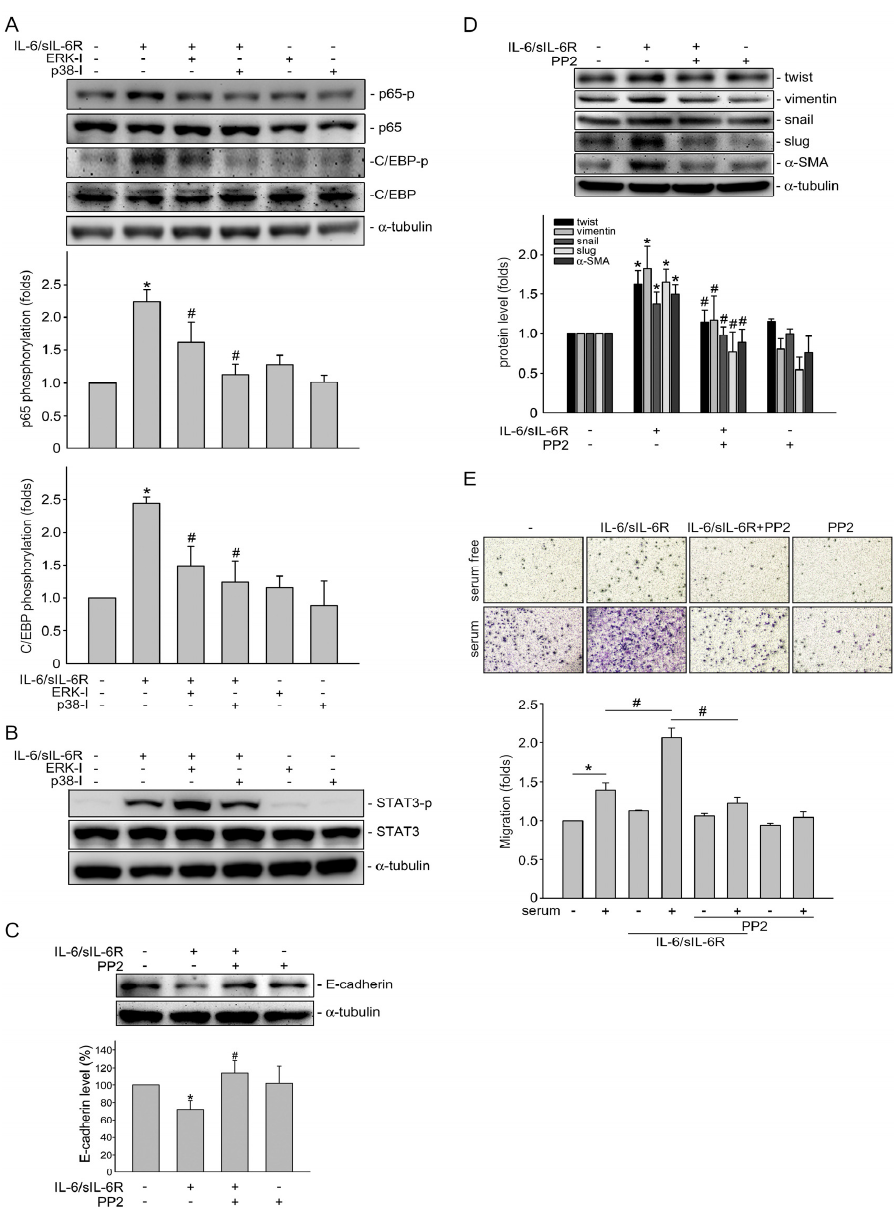
2.5. IL-6-Induced C/EBP β and p65 Phosphorylation via ERK1/2 and p38MAPK Signaling To ascertain the linkage between ERK1/2 or p38MAPK and transcription factors C/EBP β , p65 and STAT3, ERK1/2 signaling inhibitor peptide I (ERK-I) and p38MAPK inhibitor III (p38-I) were employed. As shown in Figure 6A, both inhibitors significantly reduced p65 and C/EBP β phosphorylation in HCT116 cells after IL-6/sIL-6R exposure. In contrast, IL-6/sIL-6R-induced STAT3 phosphorylation was not altered in the presence of ERK-I or p38-I (Figure 6B). These results indicated that IL-6/sIL-6R-activated NF κ B and C/EBP β could be attributed to the activation of ERK1/2 and p38MAPK signaling. However, there may be no association between ERK1/2 or p38MAPK signaling and STAT3 phosphorylation under IL-6/sIL-6R stimulation.